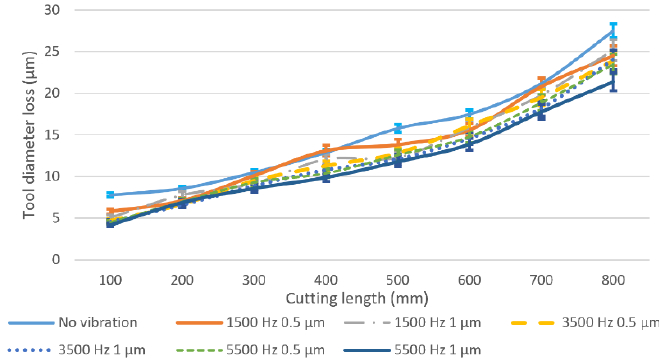
Figure 8. Tool edge radius variation under different vibration conditions and cutting length.